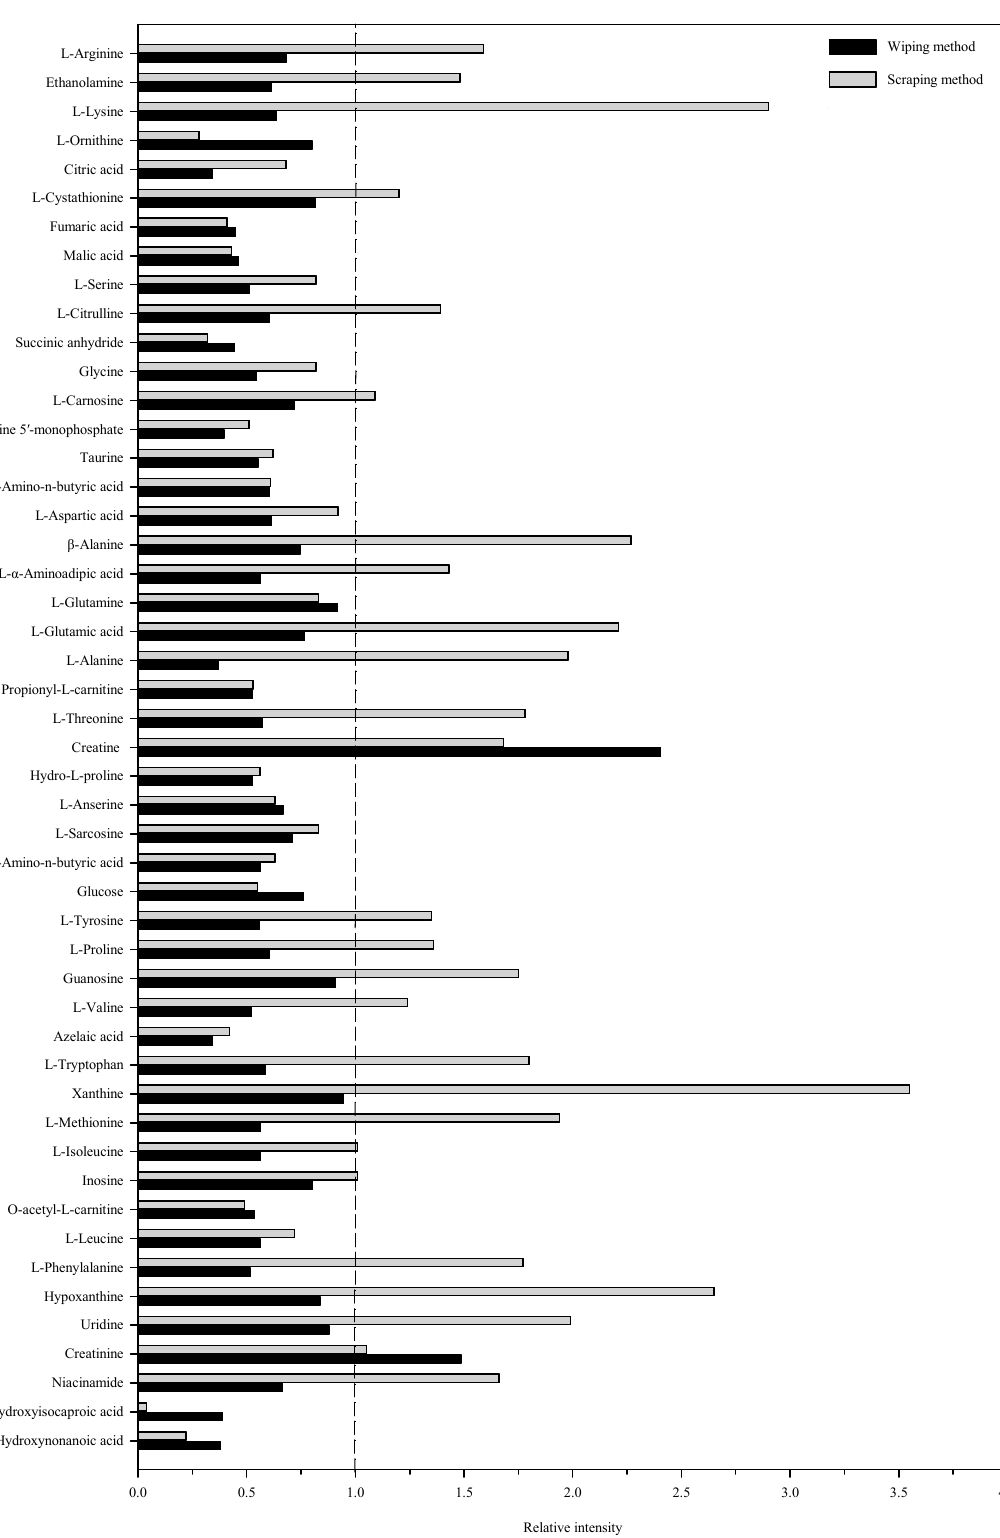
Figure 2. Comparison of mean peak areas from normalization by sum of target metabolites from salmon skin mucus, which was collected with three different sampling methods. The relative mean peak areas in the samples obtained with the filter absorption method were set to 1 (dashed line). The plot shows the variation of mean peak areas of individual metabolites between different sampling methods.